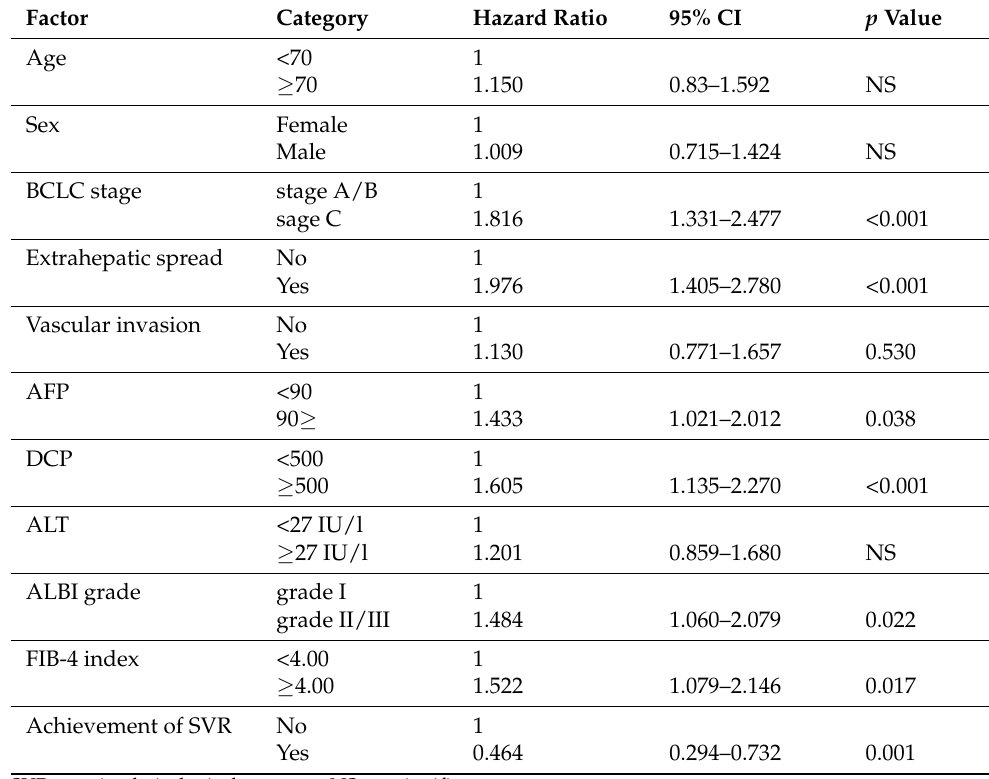
Table 2. Prognostic factors for OS in HCV-related HCC patients after molecular targeted chemotherapy.